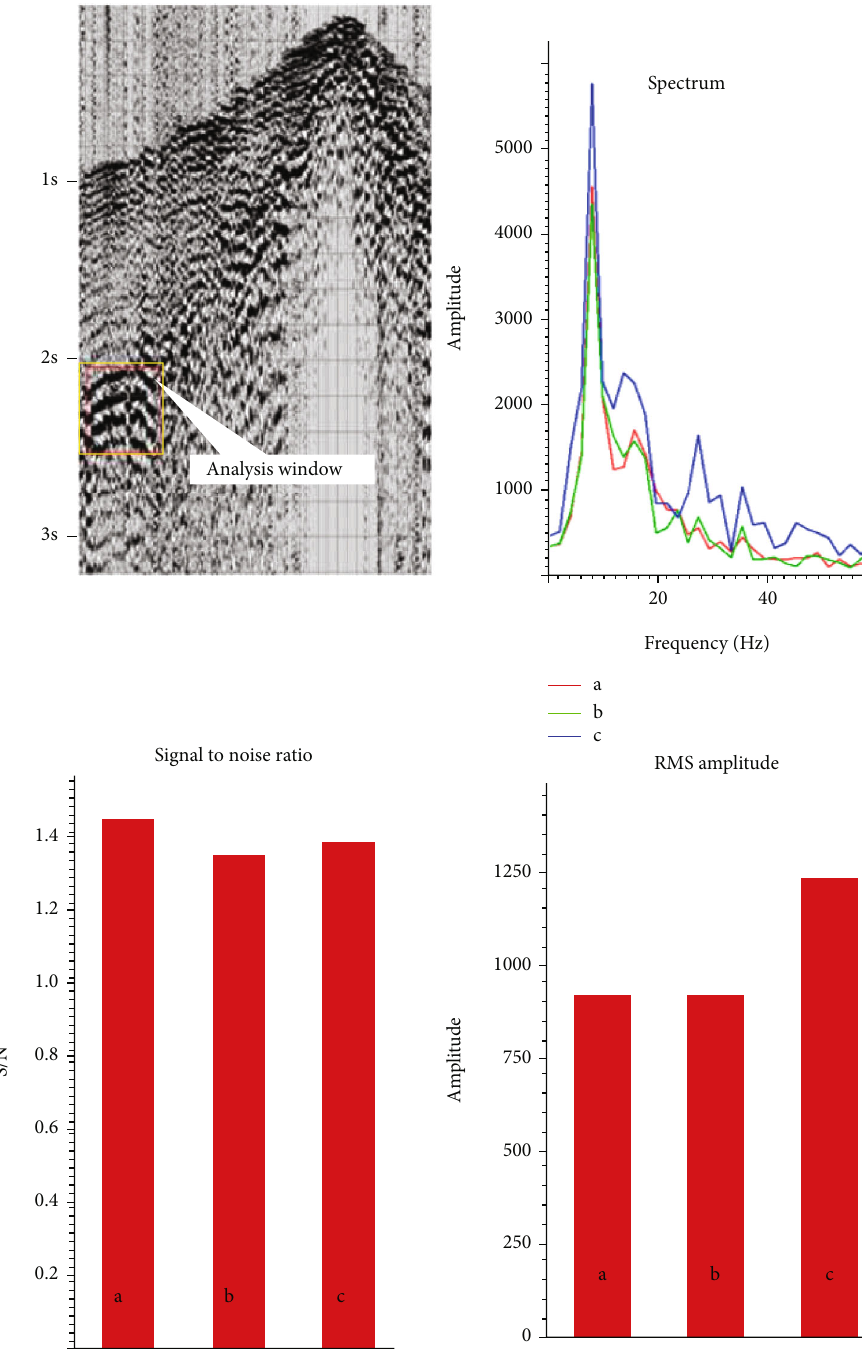
Figure 7: Quantitative analysis of receivers (a: 20 conventional geophones; b: 10 conventional geophones; c: a high-sensitivity corresponds to the ZO two-way travel time, and v surface velocity. The emergence angle of the central ray is given by α , and the radius of curvature of the normal (N) wave and the normal incidence point (NIP) wave are indicated by R and R , respectively. In application of the CRS stack, N NIP optimum values for these three parameters ( α , R automatically determined independently for each Z , x ). This is realized by varying the three parameters ( t 0 0